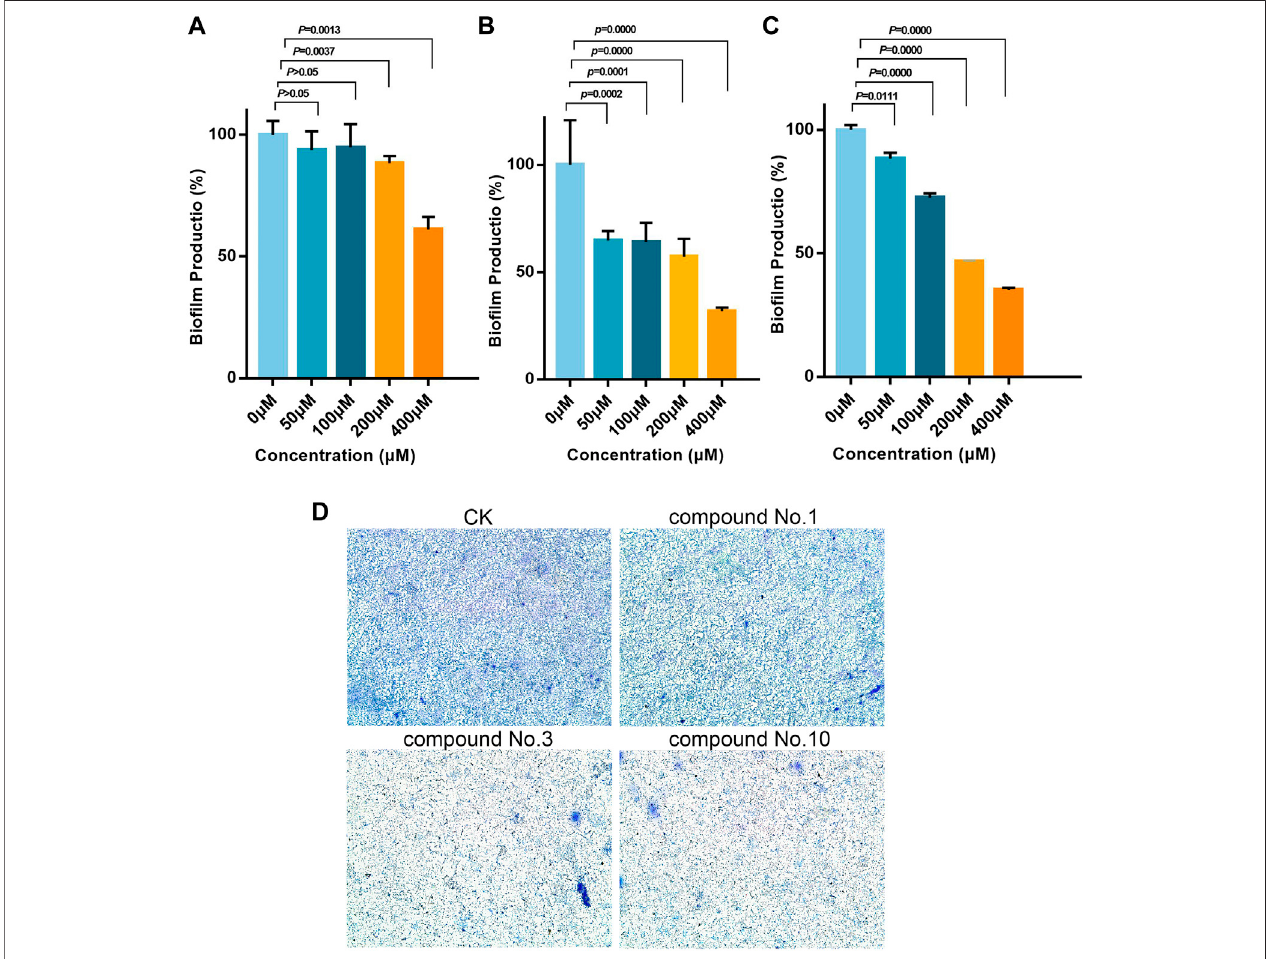
FIGURE 4 | Inhibitory effect of compound no.3 and compound no.10 on P. aeruginosa bio fi lm formation. Bio fi lm was stained by crystal violet and measured as absorbance at 570 nm. (A) Compound no.1, (B) compound no.3, (C) and compound no.10. (D) Representative microscope images of treated with compounds at 200 μ